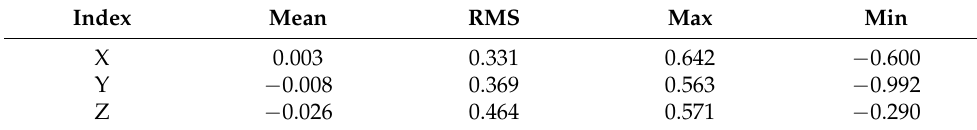
Table 4. Geometric calibration accuracy of ZY-3 three-line array camera. (Unit: meter).